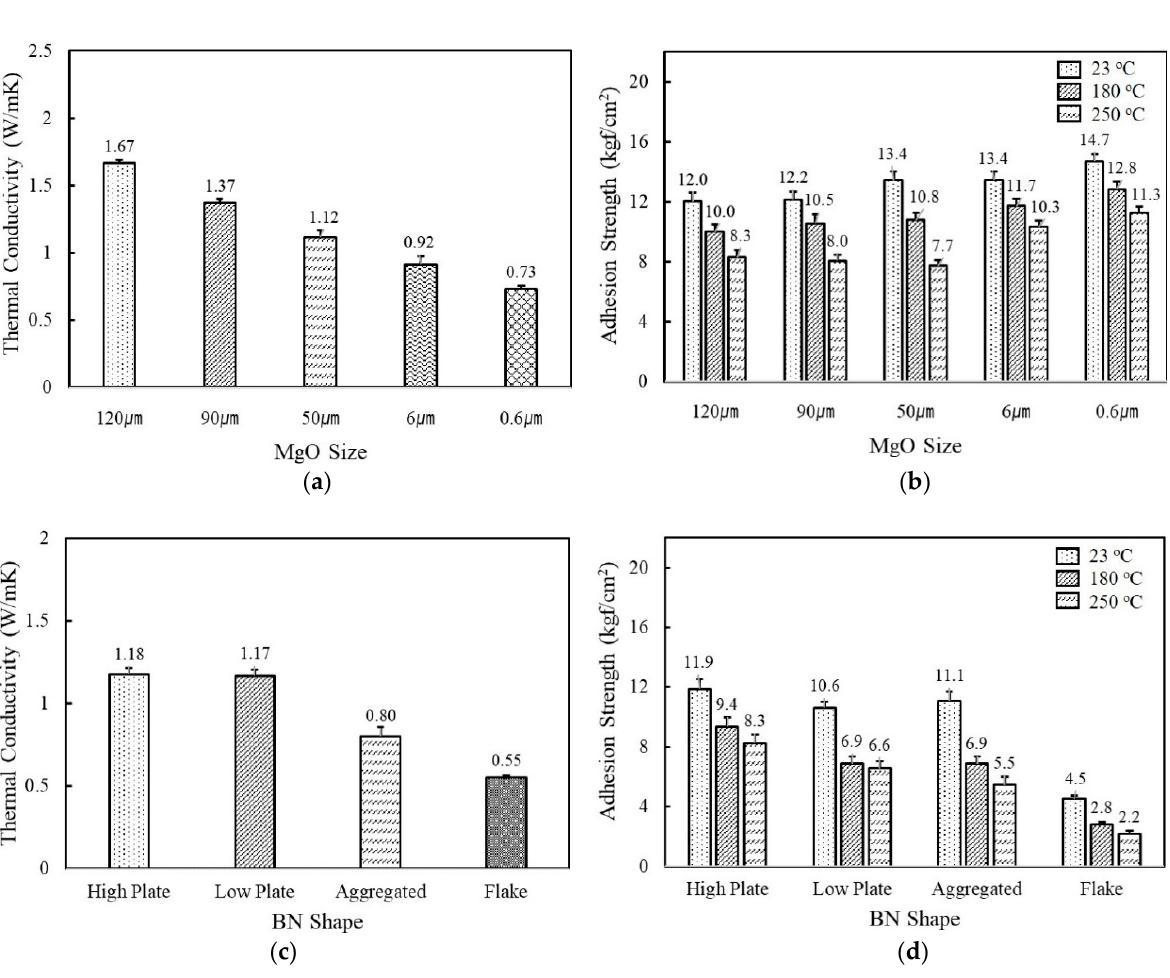
Figure 2. The thermal conductivity and adhesion strength of fluorosilicone adhesives filled with MgOs and BNs: ( a ) ther ‐ mal conductivity of MgO ‐ filled fluorosilicone; ( b ) adhesion strength of MgO ‐ filled fluorosilicone measured at 23 °C, 180 °C, and 250 °C; ( c ) thermal conductivity of BN ‐ filled fluorosilicone; ( d ) adhesion strength of BN ‐ filled fluorosilicone meas ‐ ured at 23 °C, 180 °C, and 250 °C. The filler concentration was kept at 60